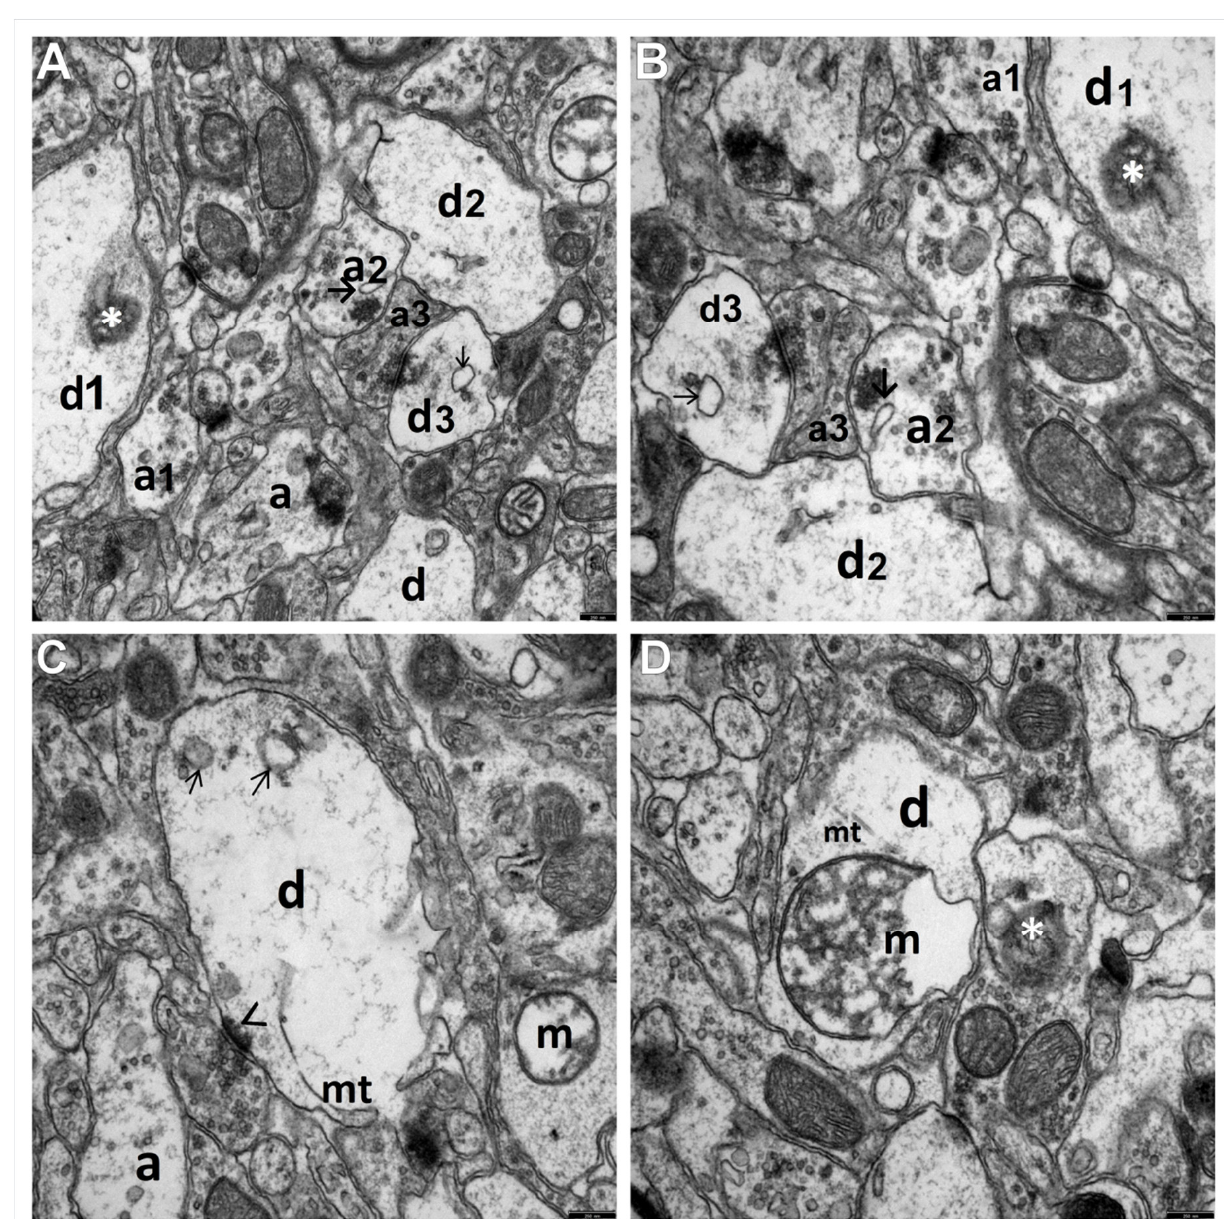
Figure 2. The electronograms show marked swelling and damage to the synaptic endings in the temporal lobe neocortex in the HS group. ( A , B ) Most visible is a group of substantially enlarged synapses; specifically, the presynaptic (a1, a2, and a3) and postsynaptic (d1, d2, and d3) parts of the synapses are remarkably swollen, filled with very fine